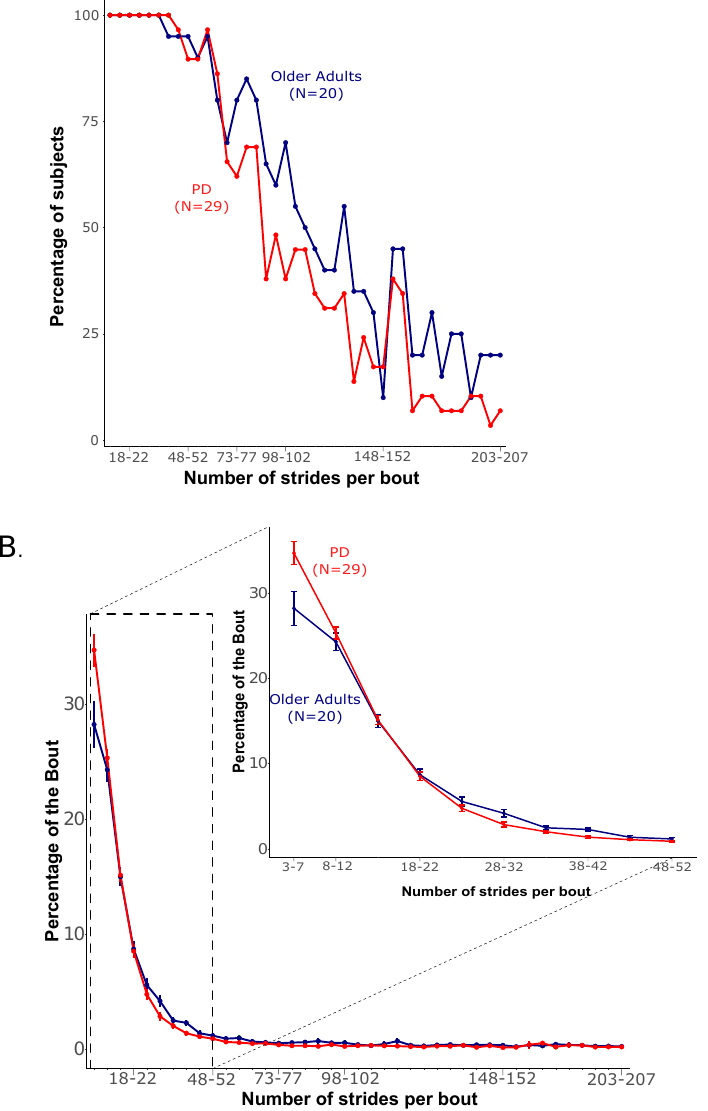
Figure 1. ( A ) Percentage of subjects walking as a function of bout length, and ( B ) percentage of all bouts performed by each participant.